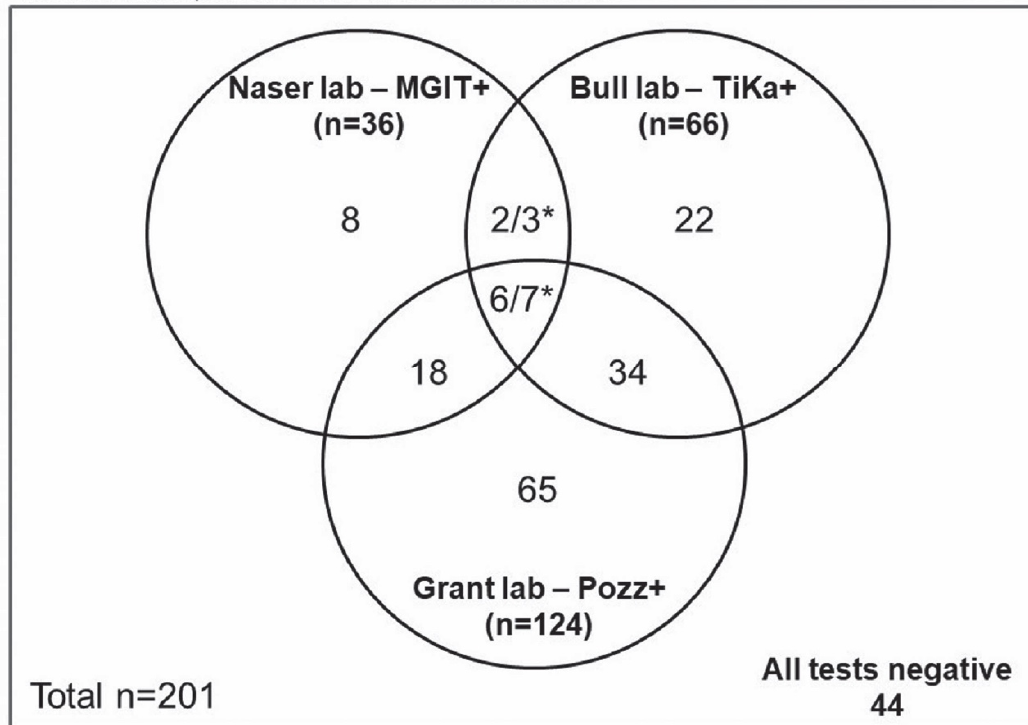
Figure 1. All positive MAP cultures from each of the culture methods and the interrelationships between the three methods. * Two samples from Bull’s lab were discarded from analysis due to non-mycobacterial contamination of media during sub-culture.